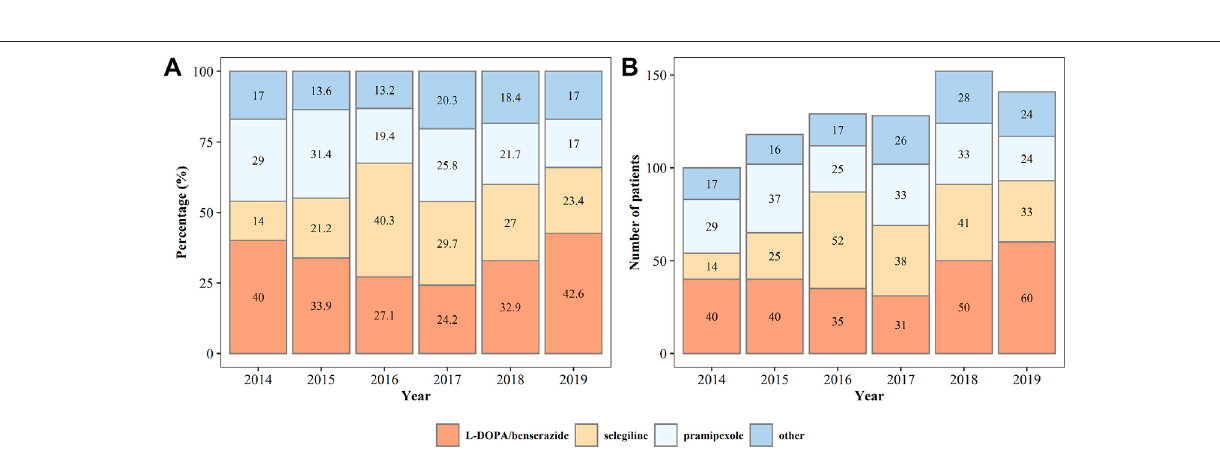
Frontiers in Pharmacology |